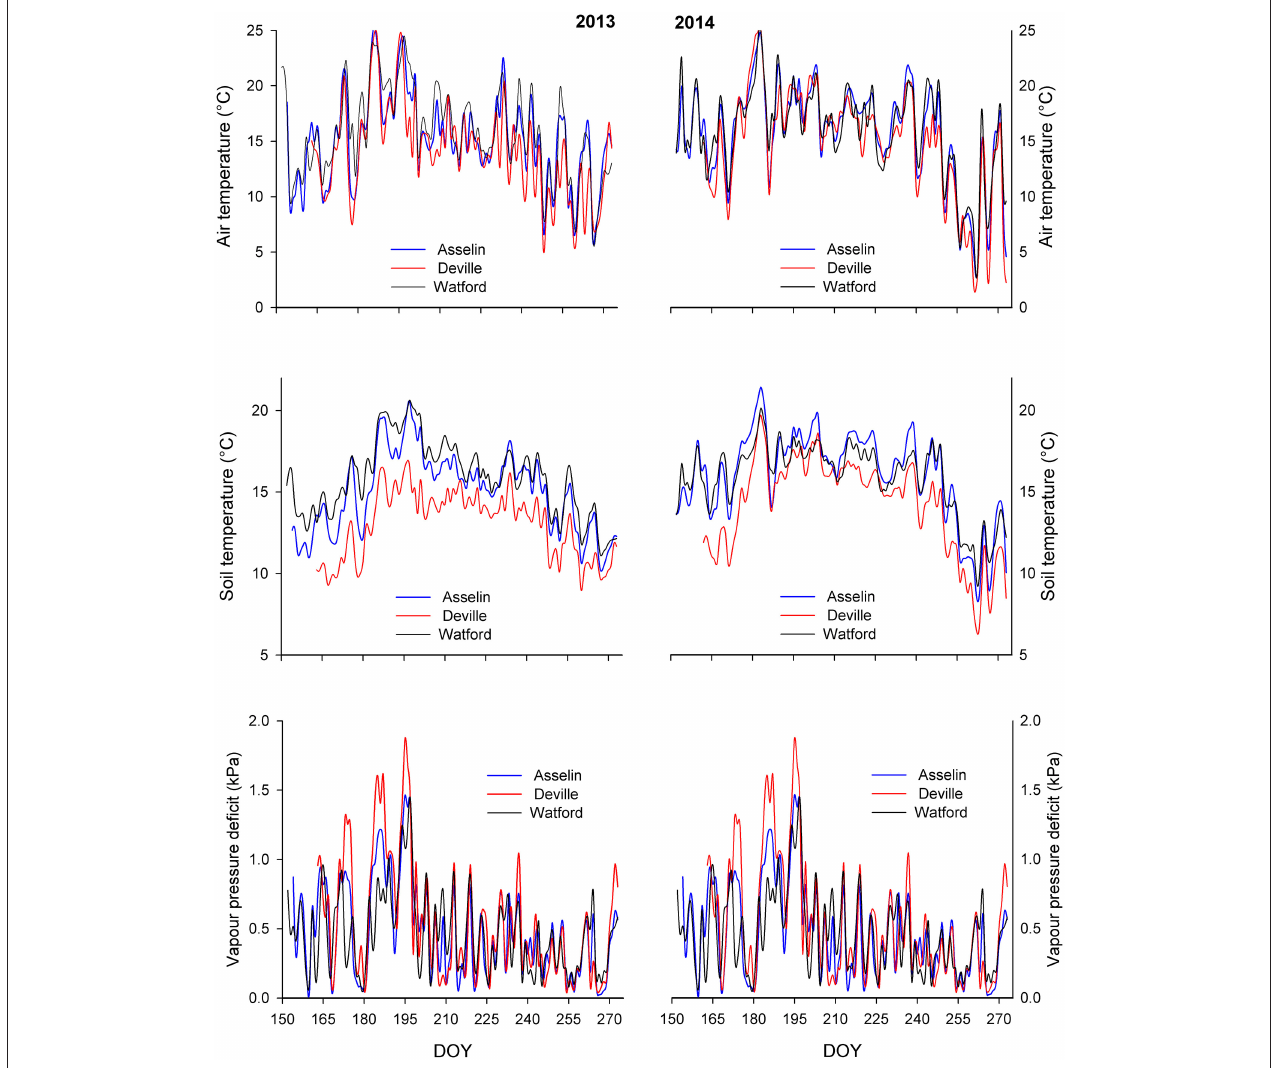
FIGURE 2 | Mean daily air temperature, mean daily soil temperature at a depth of 10cm, and mean daily air vapor pressure deficit (VPD) at the three plantation sites during the growing season of 2013 and 2014. DOY, day of year.